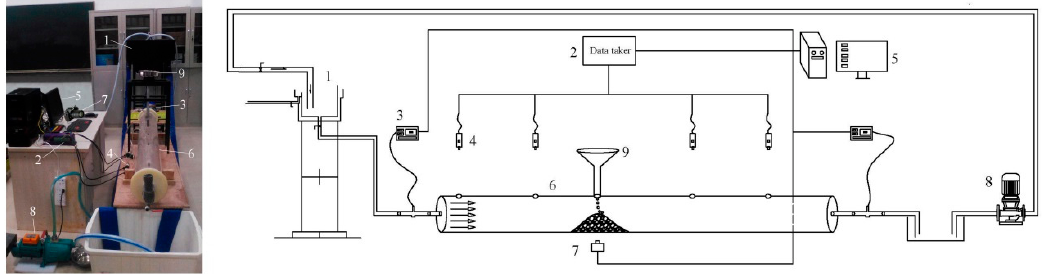
Figure 1. Photo ( left ) and schematic diagram ( right ) of experimental set-up. (1) water supply device; (2) data collection instrument; (3) water meter; (4) pressure sensor; (5) computer; (6) tunnel replica; (7) camera; (8) water pump; and (9) funnel for pouring aggregate.